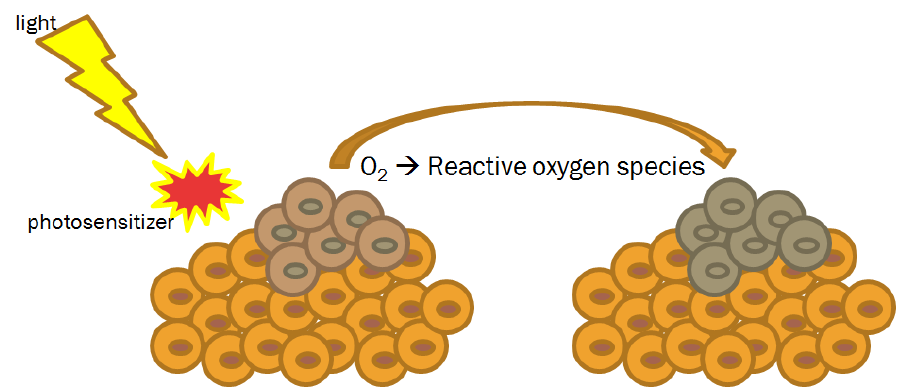
Figure 4. Photodynamic therapy: mechanism of action.